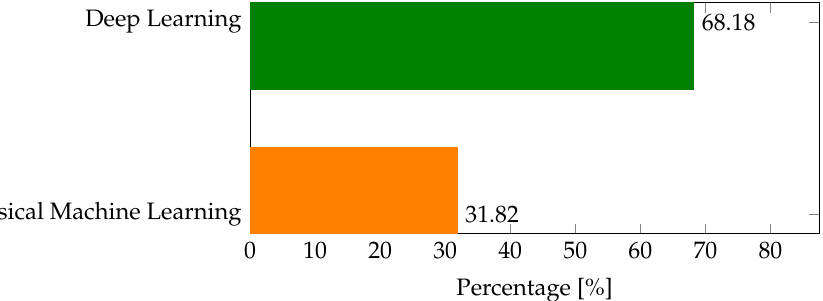
Figure 8. Paper distribution in terms of classical machine learning and deep learning-based techniques.